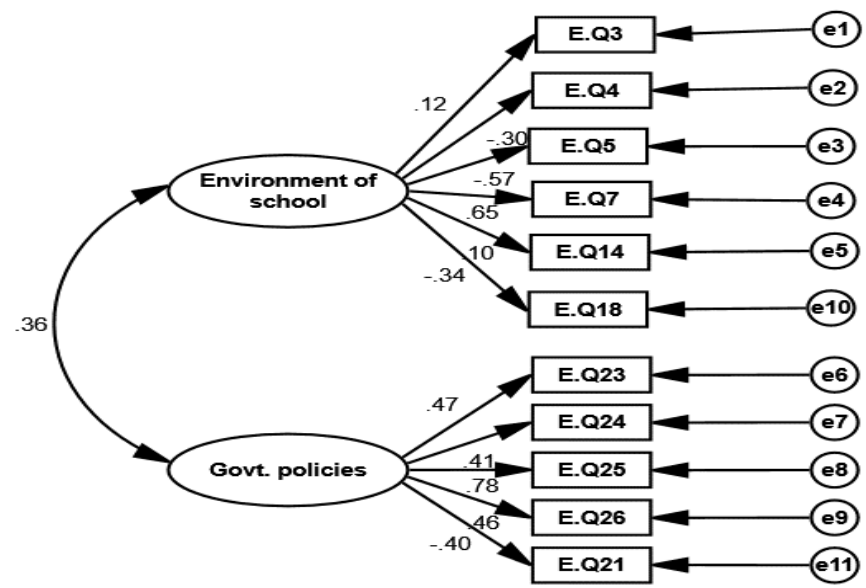
Figure 16. Standardized estimates of the school environment.